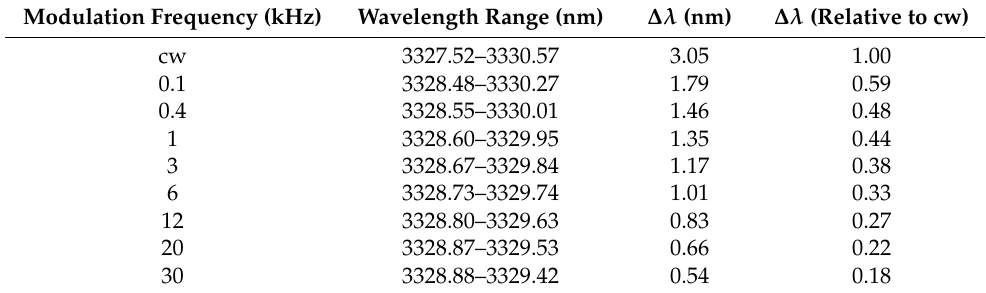
Table 2. Spectral range of nanoplus ICL 1541.